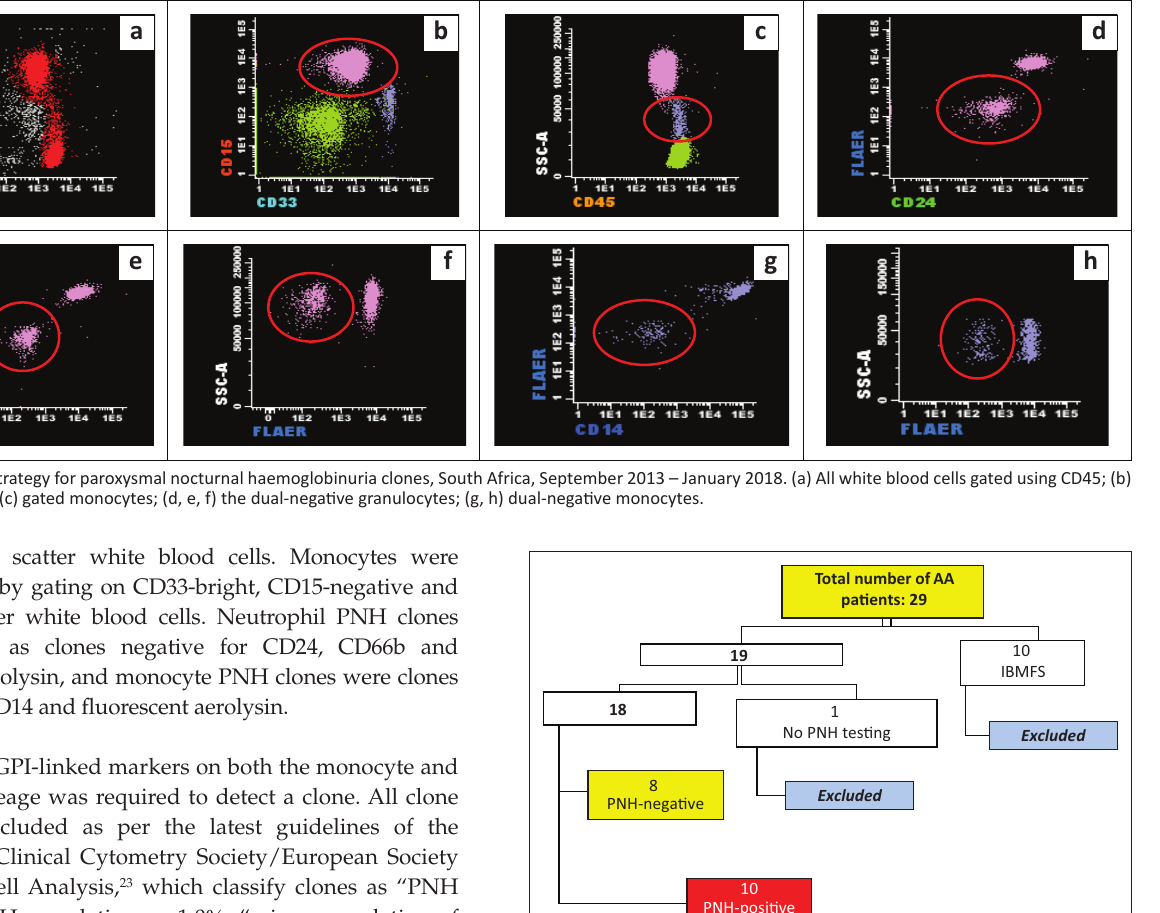
FIGURE 2: Study inclusion and exclusion criteria for patients with aplastic anaemia at the Inkosi Albert Luthuli Central Hospital, Durban, South Africa, September 2013 – January